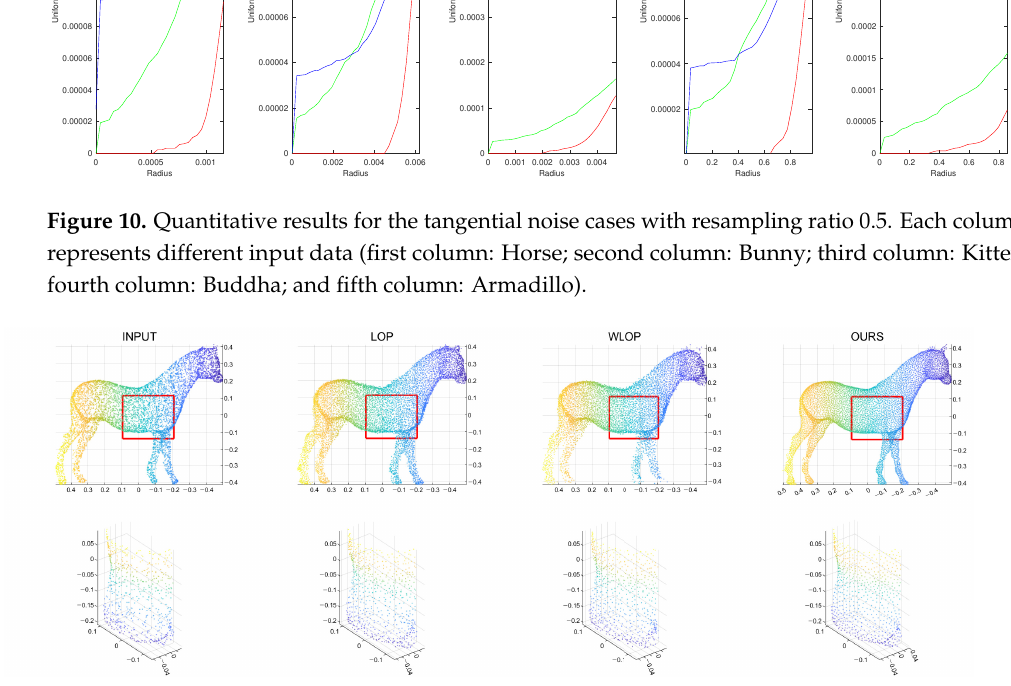
Figure 11. Qualitative results for a tangential noise case with resampling ratio 0.5 (Horse). First column: input point cloud; second column: LOP; third column: WLOP; and fourth column: the proposed method. The second row shows enlarged views of the first row.